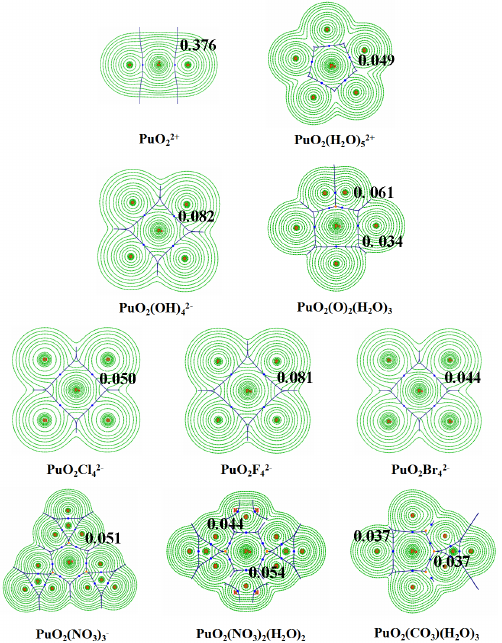
Figure 3. Electron density in the equatorial plane of studied plutonyl (VI) complexes, the BCPs are shown as the small blue sphere; the thin green lines represent the counter map of density; thin blue lines represent the interatomic paths that separate the atom electron density basins; the values of the density at the BCPs are also